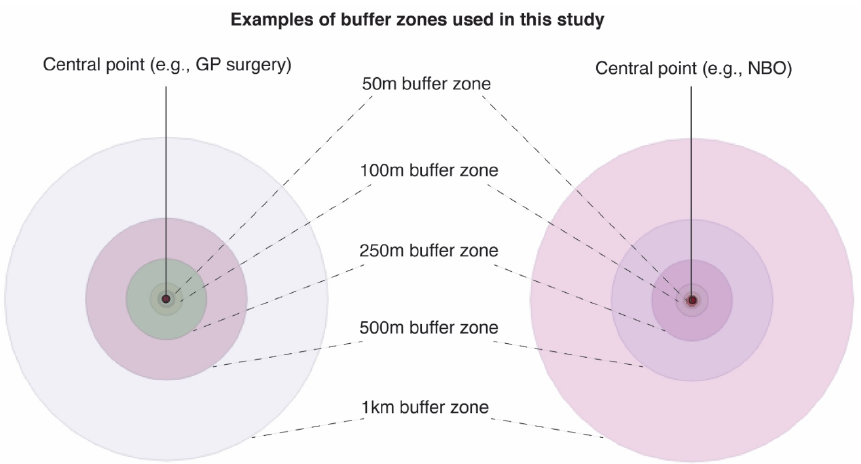
Figure 2. Example of buffer zones created around each point file containing attribute data (spatial information and questionnaire responses) for GPs and nature-based organisations in the UK.